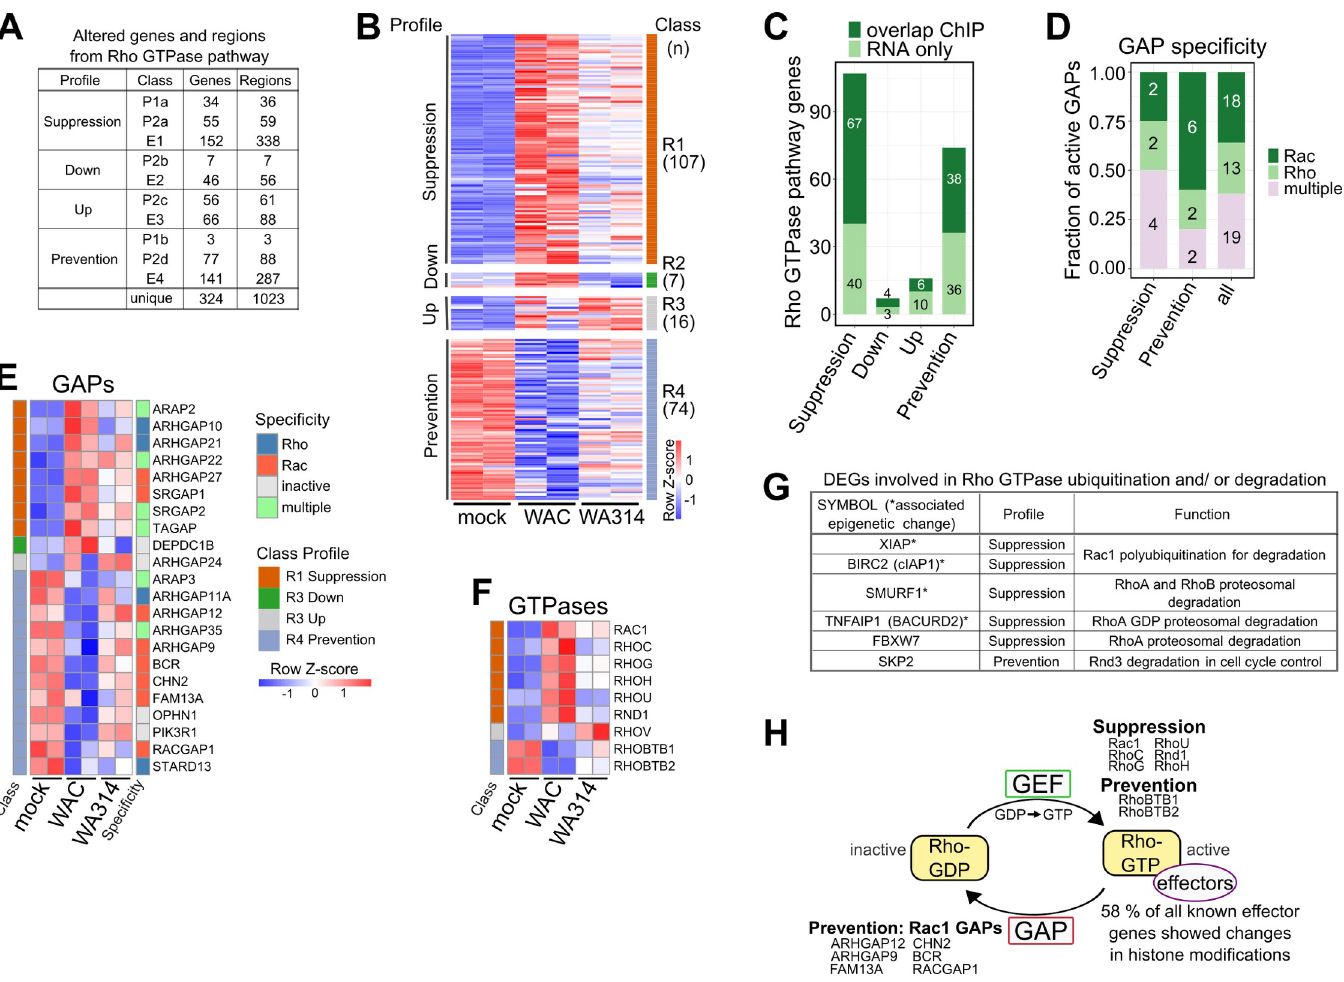
Fig 4. Epigenetic and transcriptional regulation of Rho GTPase pathway genes in Y . enterocolitica infected macrophages. A, Number of Rho GTPase pathway genes associated with changed regions in promoter (P1-b, P2a-d) or enhancer (E1-4) classes. “Unique” refers to total unique genes or regions (overlapping regions were merged together) when counting together all promoter and enhancer classes. B, Heatmap of all DEGs from Rho GTPase pathway belonging to classes R1-R4 (color coded, right side) in Fig 3A. Association with profiles is shown on the left side. “n” refers to the number of genes. Gene rlog counts were row-scaled (row Z-score). C, Bar plot showing number of DEGs belonging to Rho GTPase pathway from RNA-seq profiles in (B) overlapping with genes with corresponding promoter (P1a-b, P2a-d classes) and/ or enhancer (E1-4 classes) changes from the same profiles. D, Bar plot showing Rho GTPase specificity of active GAPs [90] for genes with RNA-seq and ChIP-seq overlaps in (C). Fraction and number (in bars) for all active GAPs and for GAPs in the Suppression and Prevention profiles are shown. E, F, Heatmaps of RNA-seq rlog counts for GAP (E) and Rho GTPase genes (F) with RNA-seq and ChIP-seq overlaps in (C) . Associated classes are indicated on the left and specificity of GAPs for Rho GTPases is indicated on the right. Gene rlog counts were row-scaled (row Z-score). G, Table showing DEGs (from Fig 3A and S6 Table) known to regulate ubiquitination and/ or proteosomal degradation of Rho GTPases. H, Schematic representation of Rho GTPase cycle showing reprogrammed Rho GTPase pathway genes divided into GAPs, GEFs, Rho GTPases and effectors, and assigned to